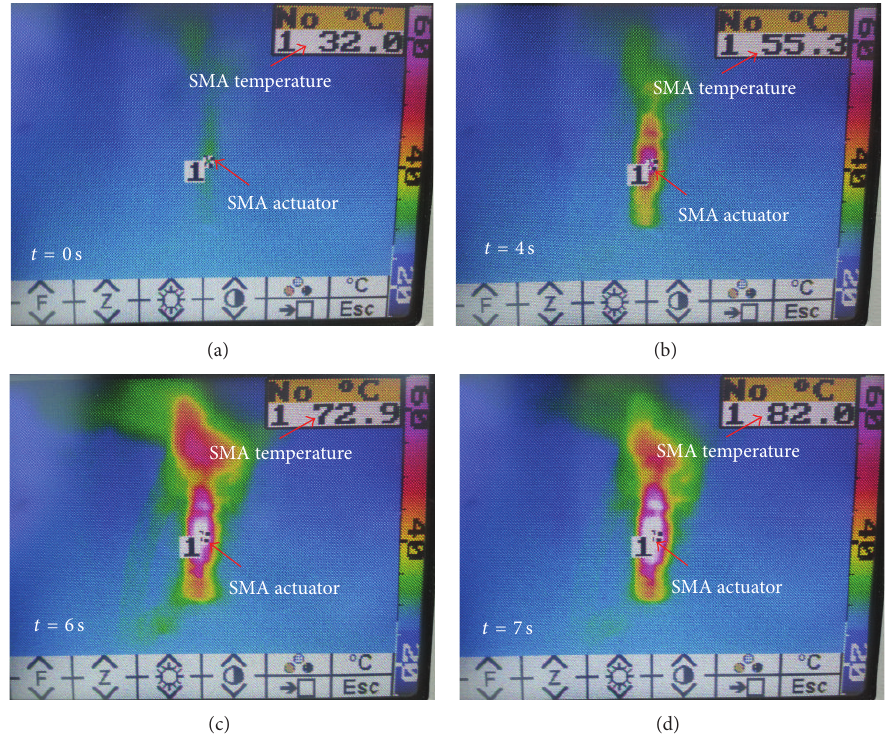
Figure 11: IR image showing transformation of SMA from martensite to austenite